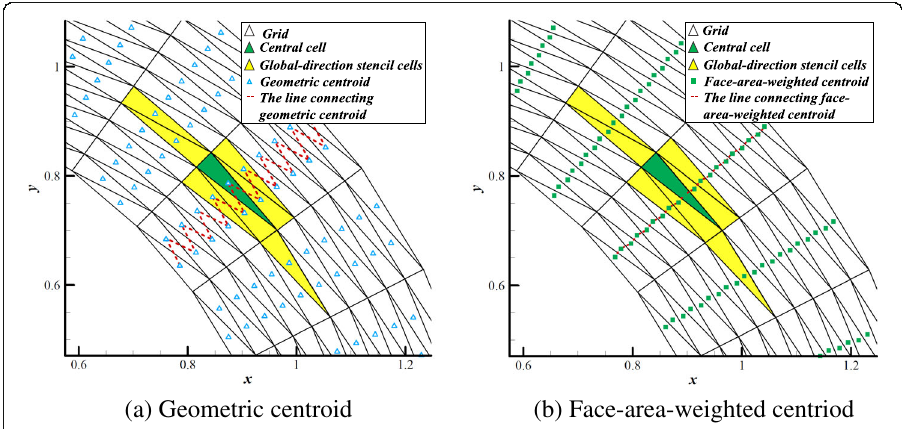
Fig. 10 Global-direction stencil cells combined with ( a ) geometric centroids and ( b ) face-area-weighted centroids on grid with the curved boundary